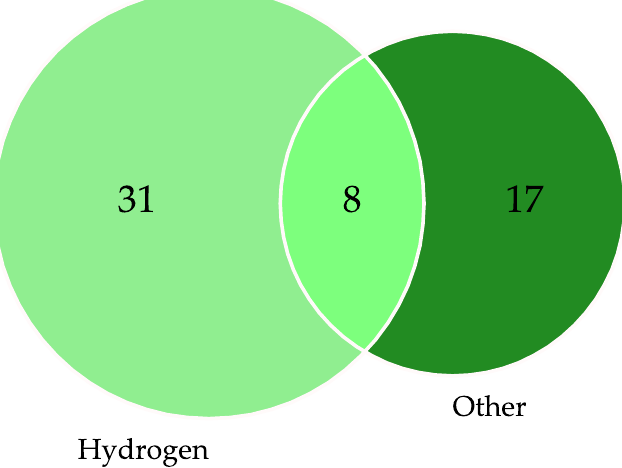
Figure 10. Number of projects per type of electrofuel produced.